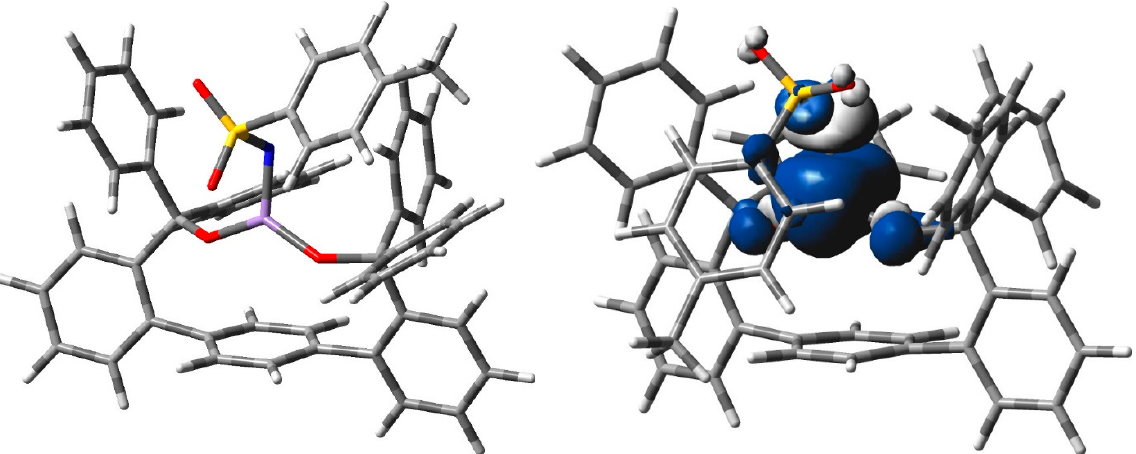
Figure 3. Optimized structure of the lowest energy quartet (left) and its spin density isosurface plotted using a cutoff value of 0.002 au (right). Blue and white surfaces correspond to excess alpha and beta spins, respectively.